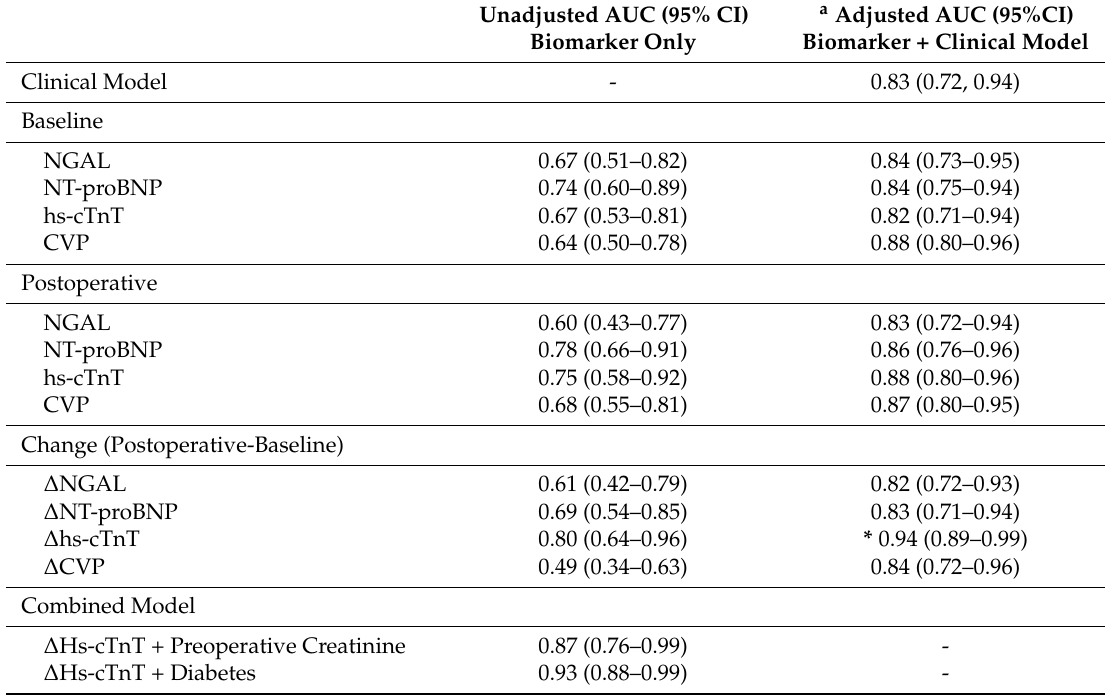
Table 3. Areas under the Receiver-Operating Curve for the prediction of congestive acute kidney